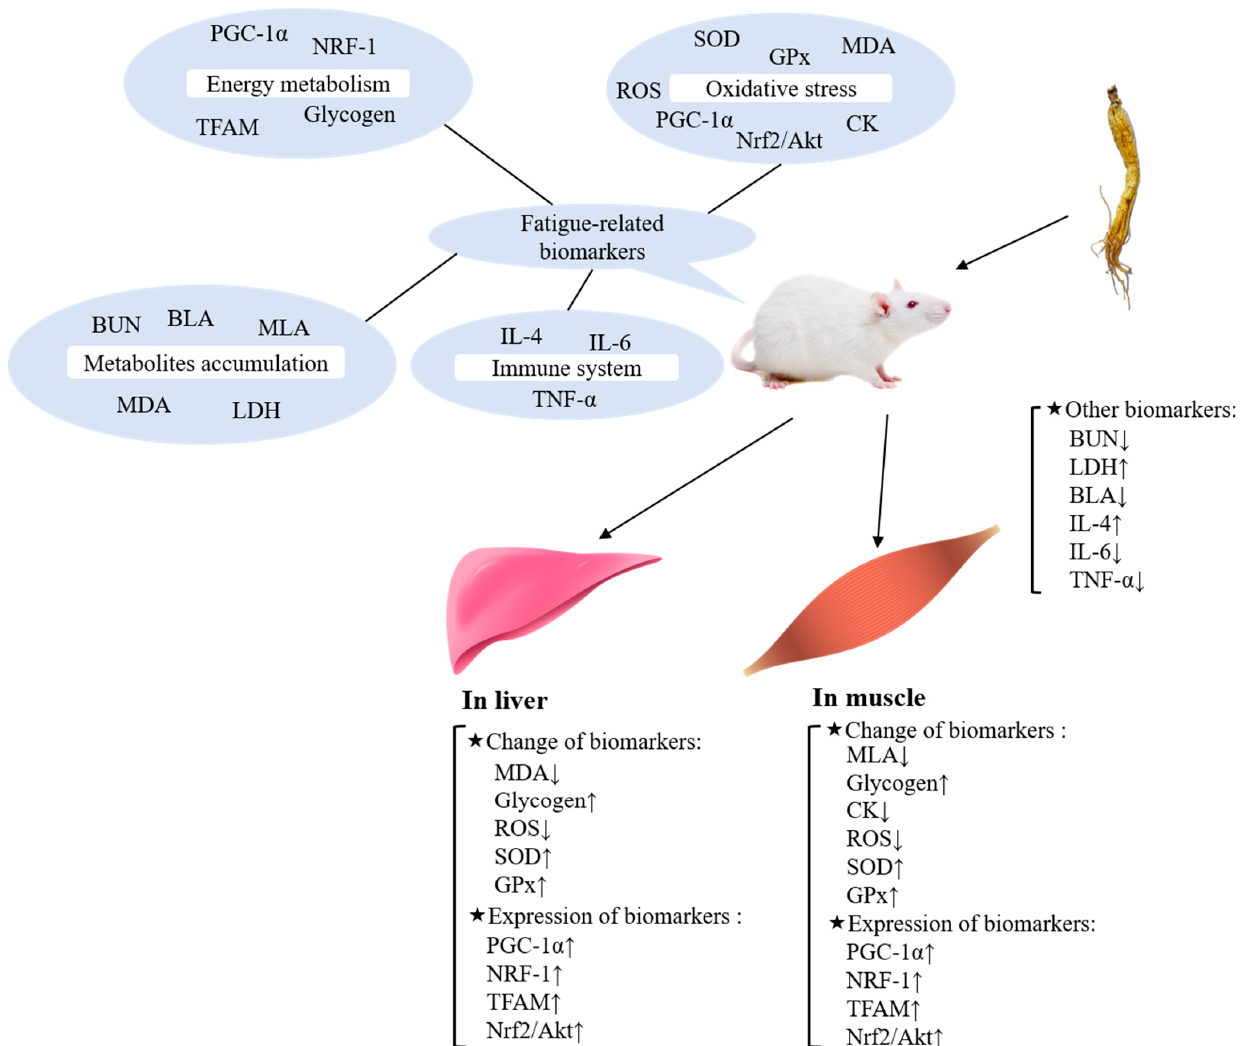
Figure 1. Major fatigue-related biomarkers and their mechanisms.